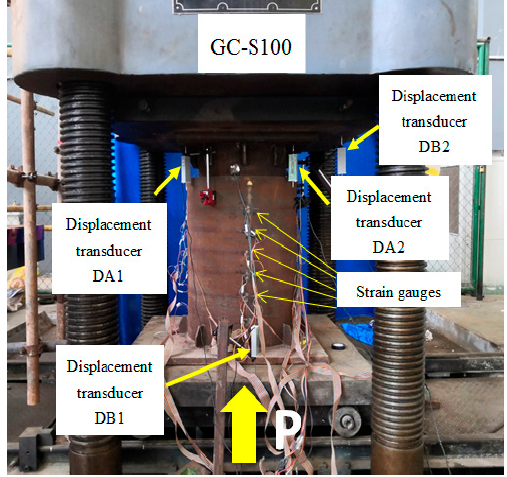
Figure 9. Schematic diagram of test points arrangement of grouted connection.